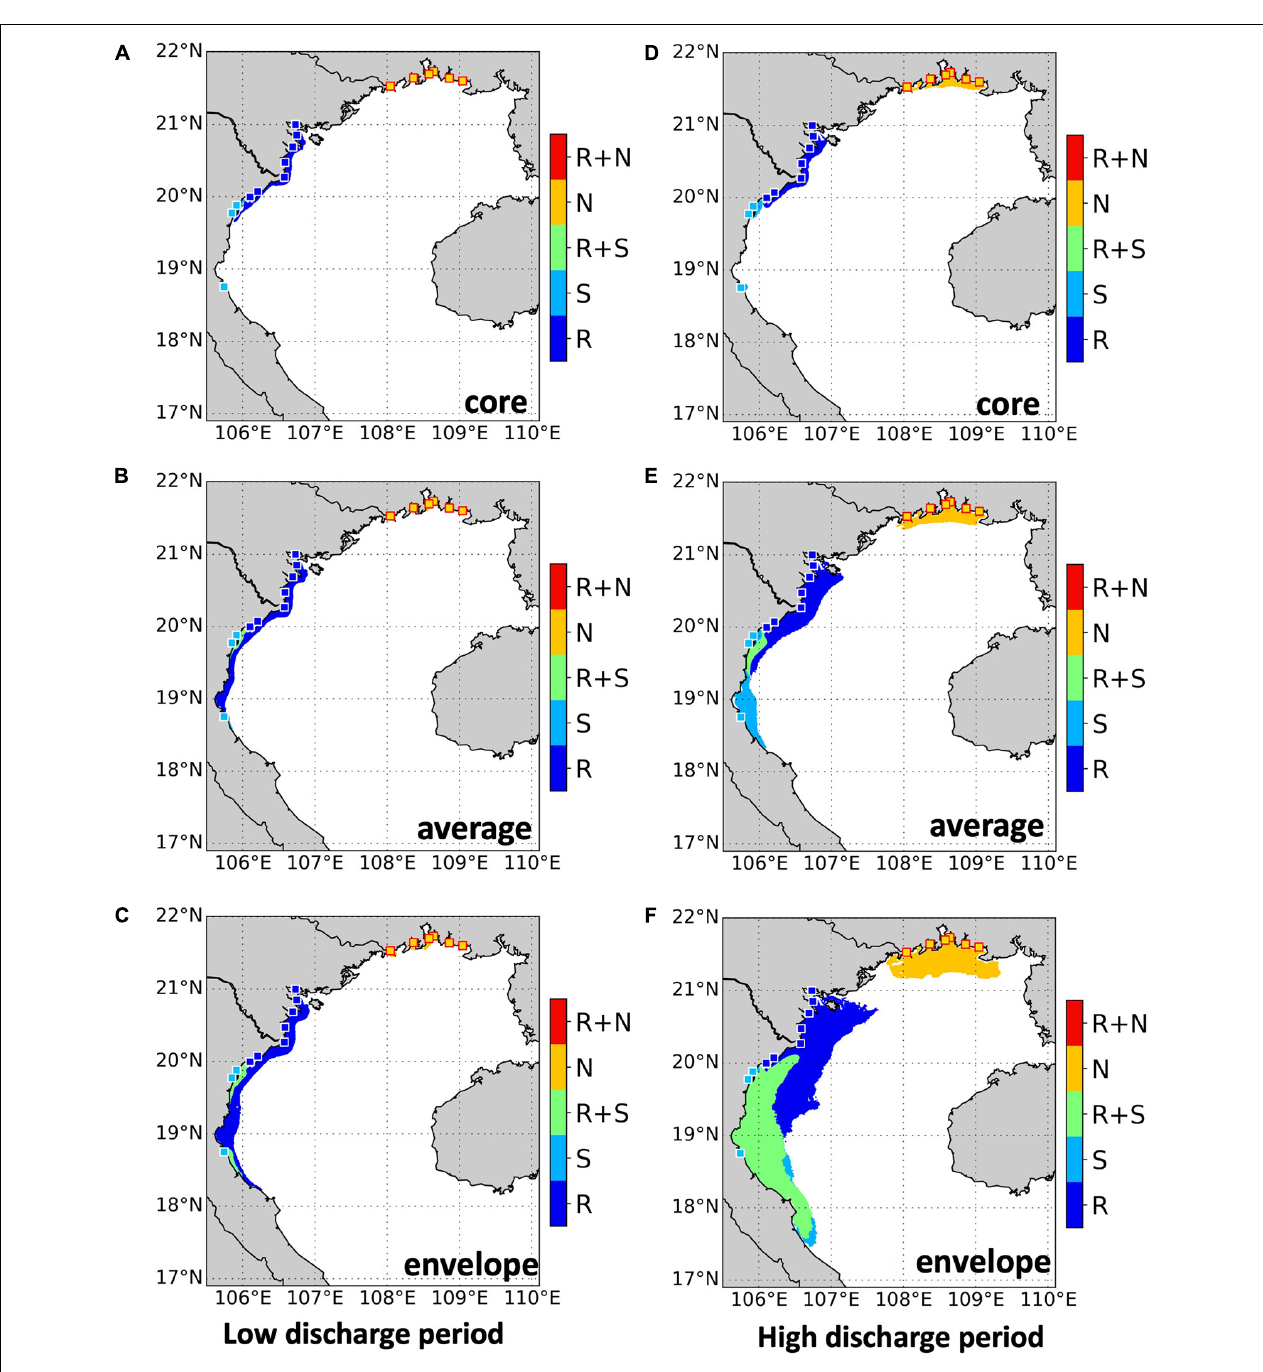
FIGURE 14 | The “receiving basins” from different rivers. The “core of the receiving basin” is the area where the plume is present at least 90% of the time (A) , the “average receiving basin” is the area where the plume is present at least 50% of the time (B) , “the envelop of the receiving basin” is the area where the plume is present at least 10% of the time (C) , all in low runoff period. (D–F) Same as (A–C) but in high runoff period. The location of the rivers is indicated by little boxes with the same color as the corresponding receiving basins. Explanation: (R): Red River plume, (S): plume of the rivers south of the RR delta, (N): the rivers north of the RR delta, (R+S): both R and S are present, (R+N): both R and N are